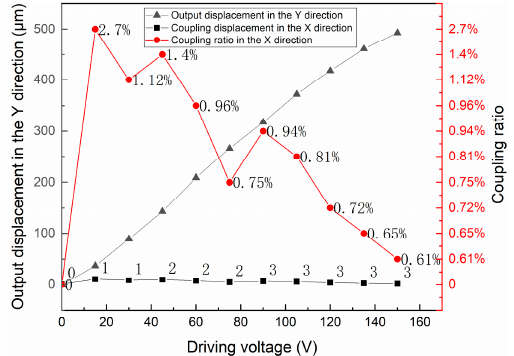
Figure 18. X-direction coupling displacement when moving in the Y direction of the platform.